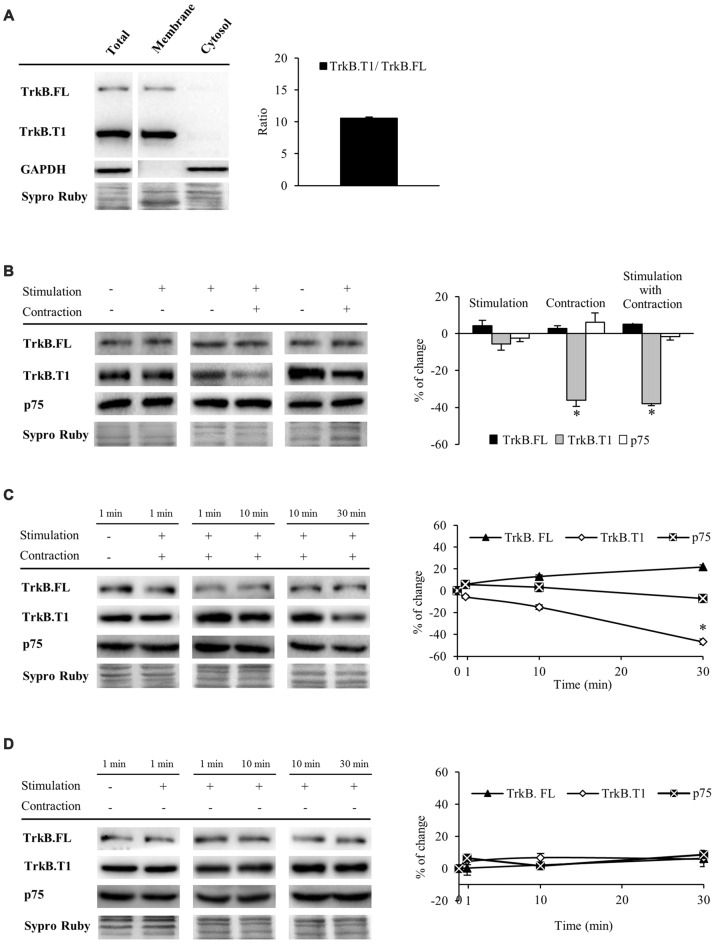
Muscle contraction reduces TrkB.T1 isoform without affecting TrkB.FL or p75 protein levels. Panels (A–D) show Western blot bands and their quantification. (A) TrkB.FL (145–150 kDa) and TrkB.T1 (95–100 kDa) were present in the total and membrane fractions and, in basal conditions, TrkB.T1 was the predominant form in the skeletal muscle. (B) TrkB.FL, TrkB.T1 and p75 receptors in presynaptic stimulation treatment, contraction treatment and presynaptic stimulation with contraction treatment at 1 Hz stimulation for 30 min. Presynaptic stimulation has been simplified as Stimulation. Each column has been compared to its respective control (see Table 1). TrkB.T1 was the only receptor modulated by activity, decreasing only when contraction was present. (C) TrkB.FL, TrkB.T1 and p75 receptors at 1, 10 and 30 min after presynaptic stimulation with contraction treatment. Each time-point has been compared to its previous time-point. Muscle contraction decreased TrkB.T1 between 10 min and 30 min, without altering TrkB.FL nor p75. (D) TrkB.FL, TrkB.T1 and p75 receptors at 1, 10 and 30 min after presynaptic stimulation treatment. Each time-point has been compared to its previous time-point. No receptor was altered without contraction. Data are mean percentage ± SEM, *p < 0.05. Abbreviations: TrkB.FL, Full Length isoform of TrkB; TrkB.T1, truncated isoform 1 of TrkB; p75, low-affinity nerve growth factor receptor.